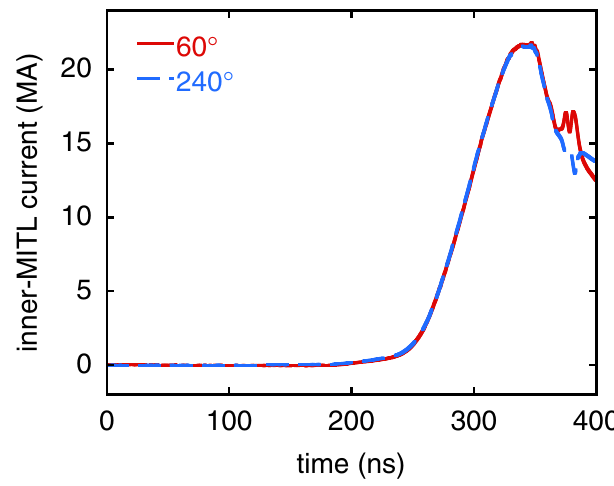
FIG. 15. (Color) Measurements on Z -shot 1548 of the inner- MITL current at 2 azimuthal locations.